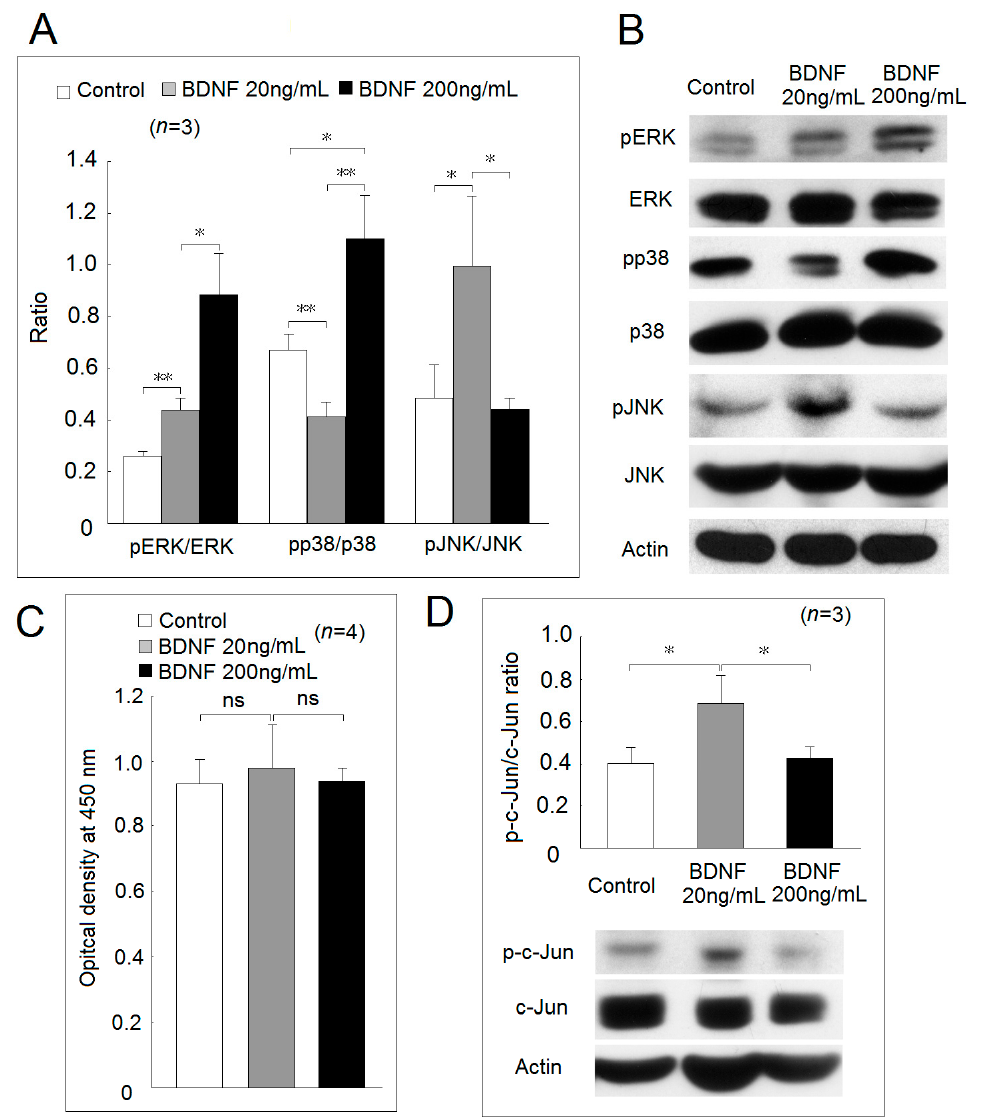
Figure 3. Effect of different concentrations of BDNF in mitogen-activated protein kinase (MAPK) phosphorylation and cell proliferation. ( A ) The phosphorylation ratio of p38, extracellular signal-regulated kinases (ERK), and c-Jun N-terminal kinases (JNK) in Jurkat cells after cocultured in culture medium with a low concentration BDNF (20 ng/mL) or a high concentration BDNF (200 ng/mL) for 48 h. ( B ) a representative case. ( C ) The viability and proliferation of Jurkat cells after cocultured in culture medium with a low and a high concentration of BDNF for 48 h analyzed by WST-1 cell proliferation assay. ( D ) The phosphorylation ratio of c-Jun in Jurkat cells after cocultured in culture medium with a low and a high concentration BDNF for 48 h ( ns , not significant; * p < 0.05; ** p < 0.01).